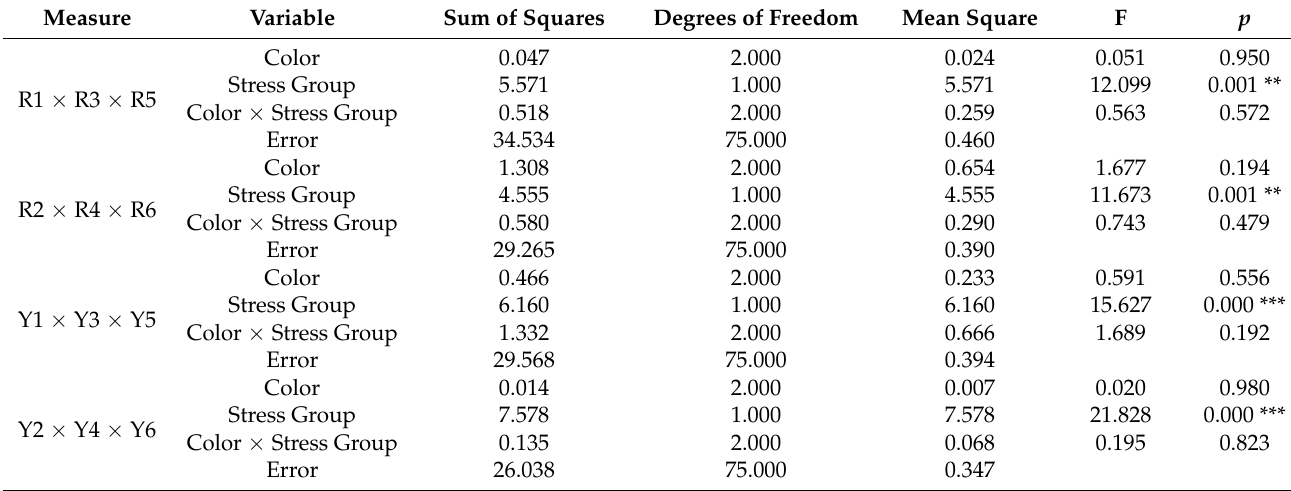
Table 13. The main effect and interaction by saturation changes and stress groups of ln(LF). Measure Variable Sum of Squares Degrees of Freedom Mean Square F